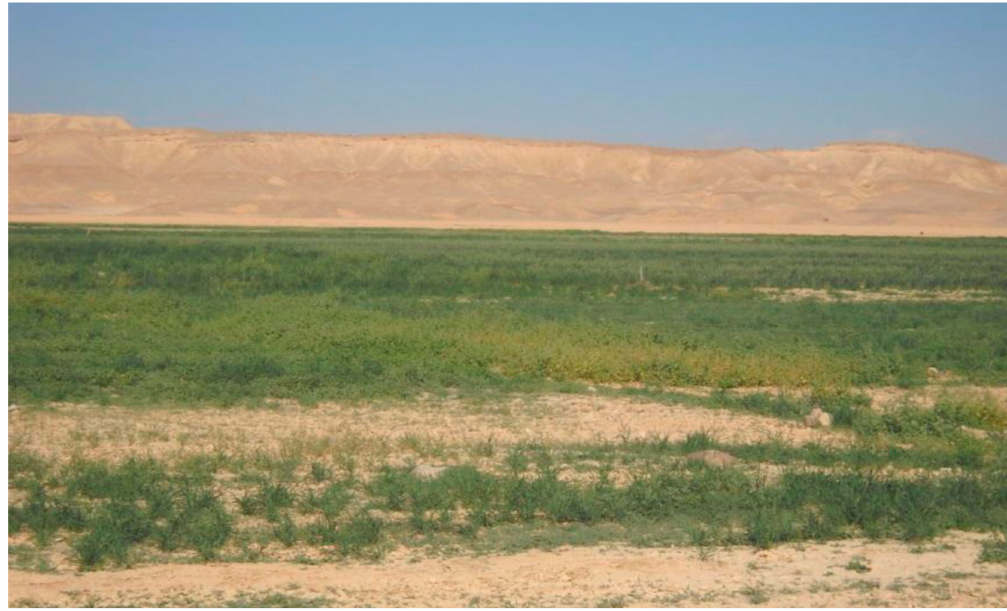
Figure 10. Dense herbaceous vegetation cover in the El-Sa’edin Playa (Qa el-Sa’edin), following the 31 January 2013 inundation. The picture was taken on 18 March 2013 by Boaz Langford. Reproduced with permission from the